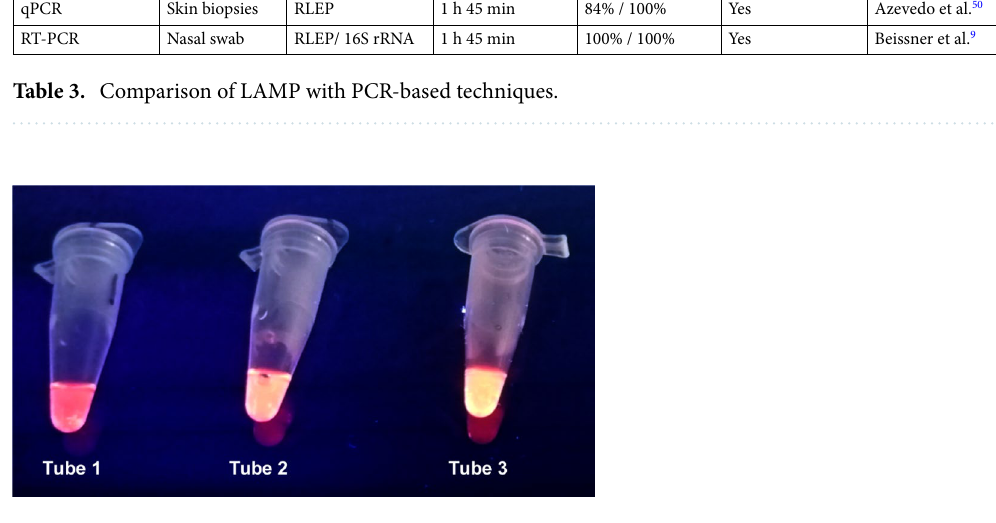
Figure 6. Propidium iodide detection of LAMP amplicons. Bright pink fluorescence (Tube 1) shows presence of amplified ML DNA in sample while negative samples, MTB control (Tube 2) and No template control (Tube 3), give orange